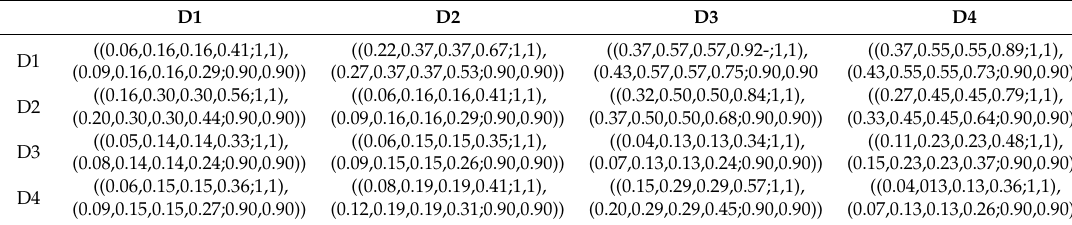
Table 6. Total relation matrix for the